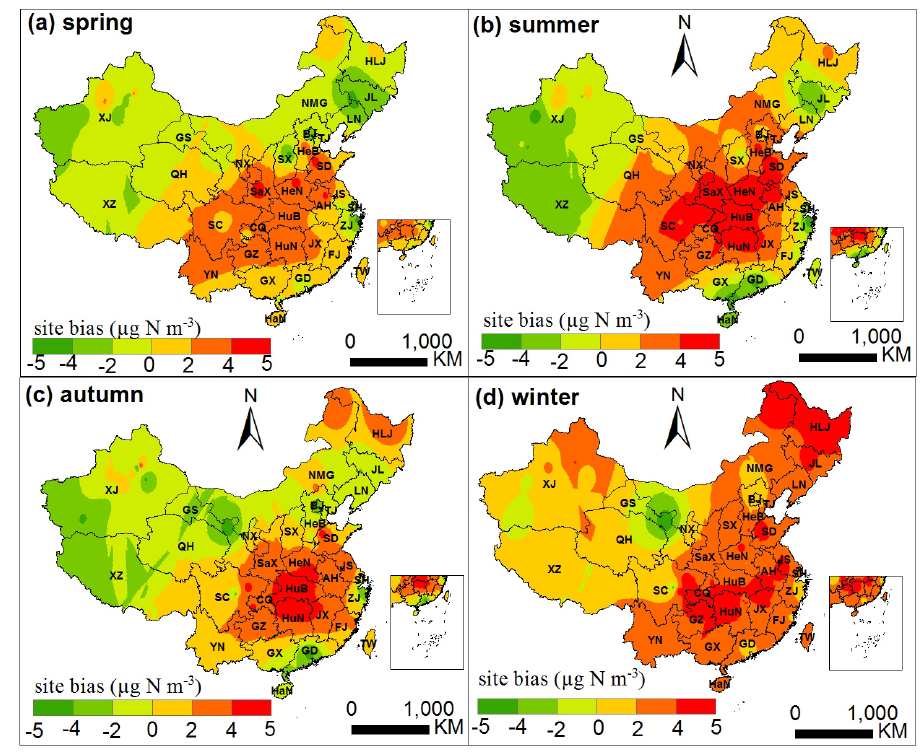
Figure A2. A quick illustration of the site bias of ground NH 3 concentrations across China by interpolating the residuals between the measured and estimated using the inverse-distance-weighted (IDW) interpolation. The figures were generated using ArcGIS 12.0 software ( https://www.arcgis.com/ ).